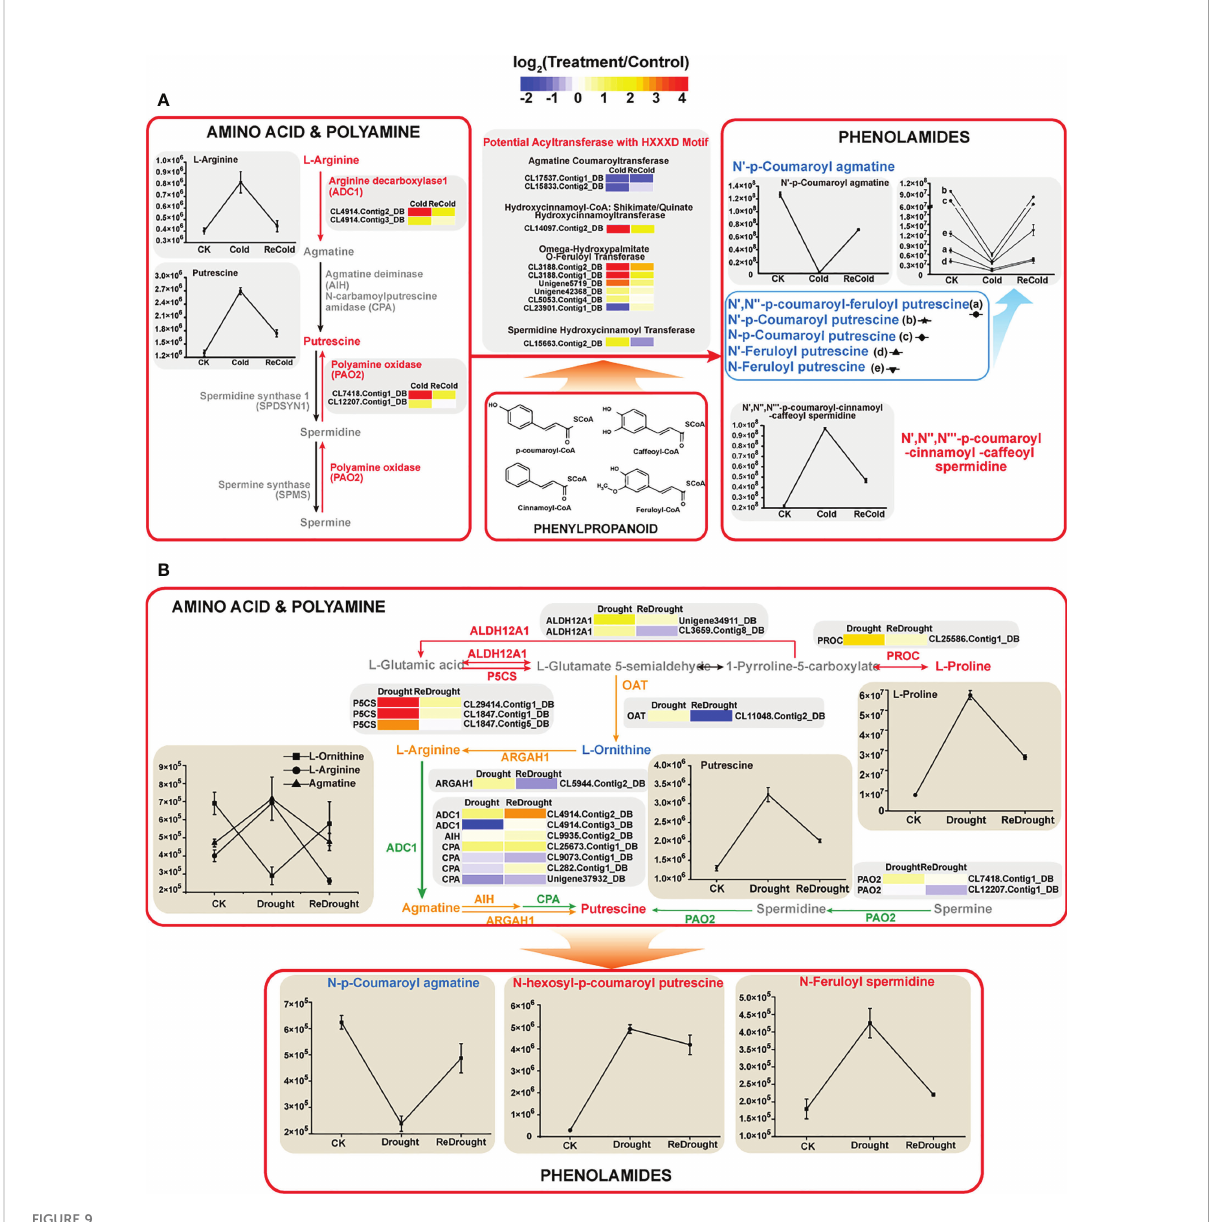
FIGURE 9 Amino compound metabolism under cold or drought stresses. (A) Cold stress. (B) Drought stress. The expression changes of genes are denoted by heat maps, and the color intensity represents the expression level. The fl uctuant contents of metabolites are represented by line charts. Red arrows and labels: genes or metabolites signi fi cantly upregulated; yellow arrows and labels: genes or metabolites moderately upregulated; green arrow and label: gene members with up- or downregulated changes. ALDH12A1, delta-1-pyrroline-5-carboxylate dehydrogenase 12A1; P5CS, delta-1-pyrroline-5-carboxylate synthase; PROC, pyrroline-5-carboxylate reductase; OAT, ornithine aminotransferase; ARGAH1, arginase; ADC, arginine decarboxylase; AIH, agmatine deiminase; CPA, N -carbamoylputrescine amidase; PAO 2 , polyamine oxidase